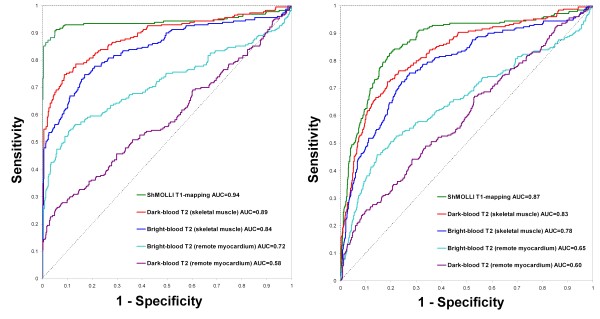
ROC curves for the detection of acute myocardial edema by ShMOLLI T1-mapping, dark-blood T2w-CMR and bright-blood T2w-CMR using only segments of good quality for all methods (left panel), and using all available segments, including segments previously rejected for artifacts for all methods (right panel.). This shows that ShMOLLI T1-mapping retains its superiority despite the re-inclusion of segments affected by artifacts. All comparisons are statistically significant (p < 0.03). AUC = area-under-the-curve.